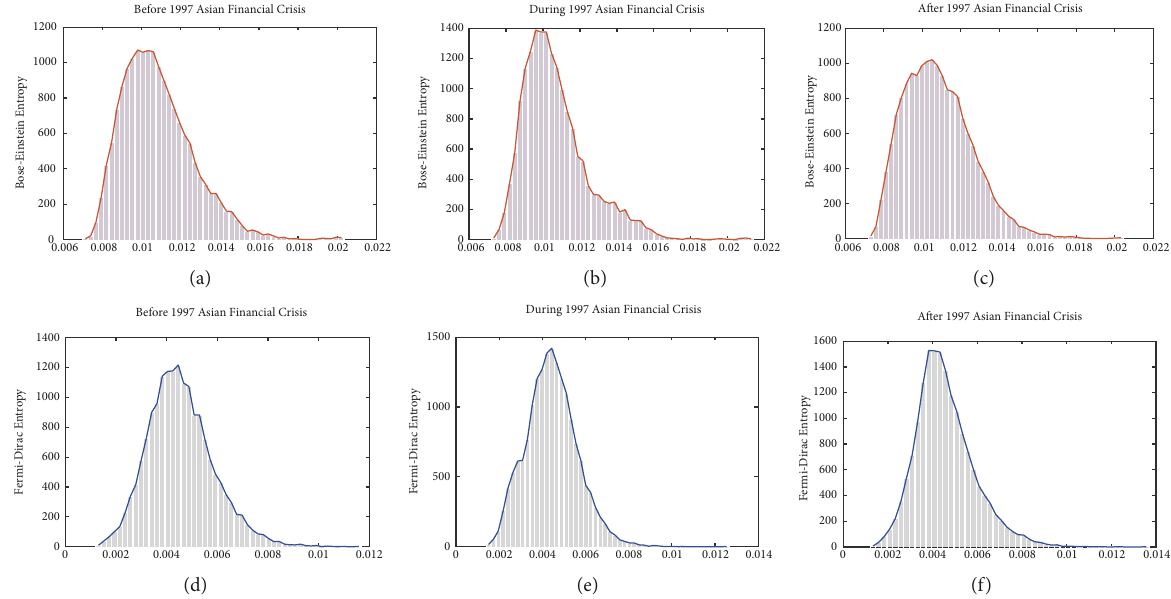
Figure 8: Edge entropy distribution of network structure before, during, and after the 1997 Asian financial crisis. (a)-(e) Bose-Einstein statistics. (d)-(f) Fermi-Dirac